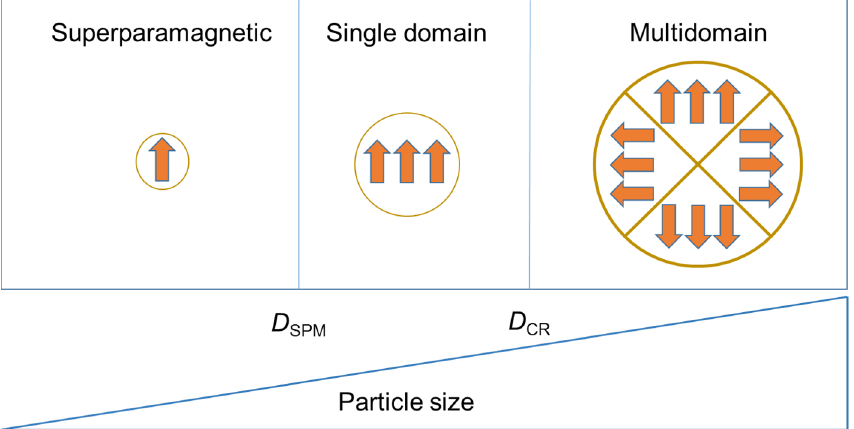
Figure 1. Magnetic regimes of ferromagnetic materials as a function of their size (superparamagnetic, single domain,